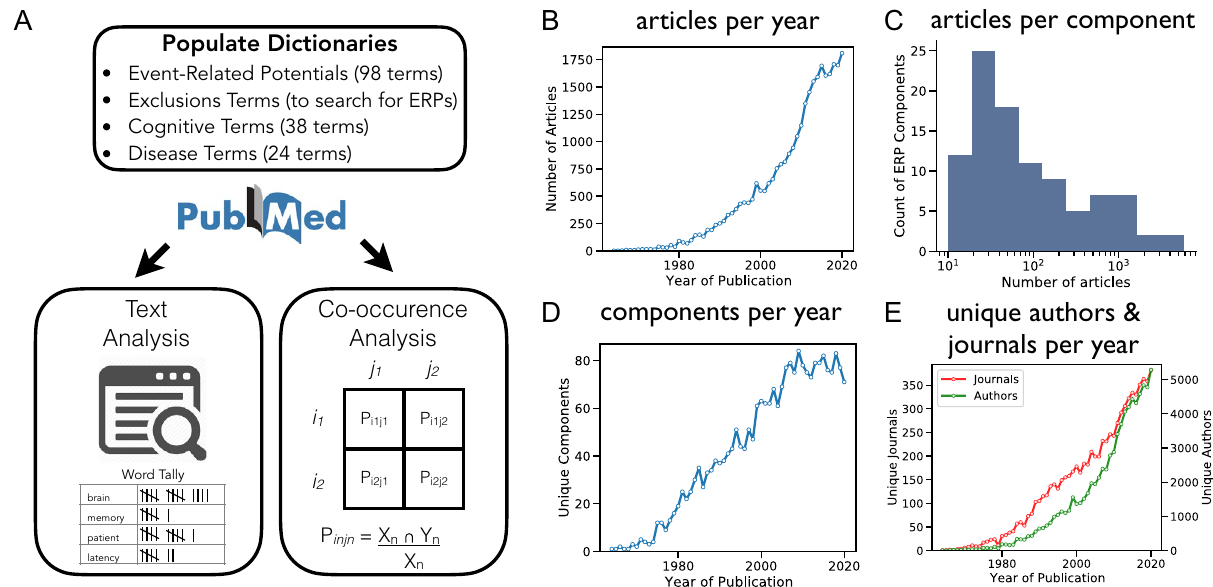
Figure 2. Data collection and dataset description. ( A ) Schematic of the data collection and analysis. B ) The number of ERP articles per year, collapsed across all components. C ) The distribution of the number of articles found across ERP components. ( D ) The number of unique components that are studied per year. ( E ) The number of unique journals and authors per year in the collected